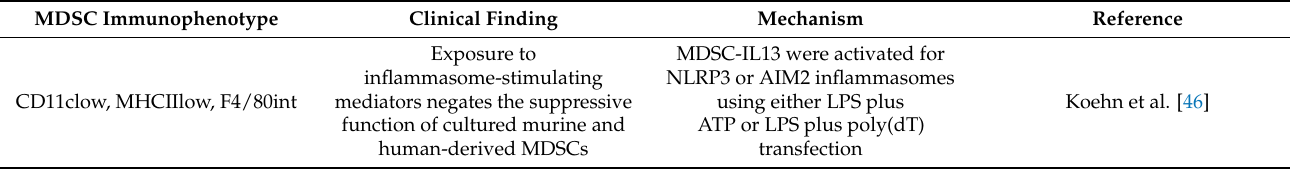
Table 1. Summary of clinical findings and mechanisms for each MDSC immunophenotype. MDSC